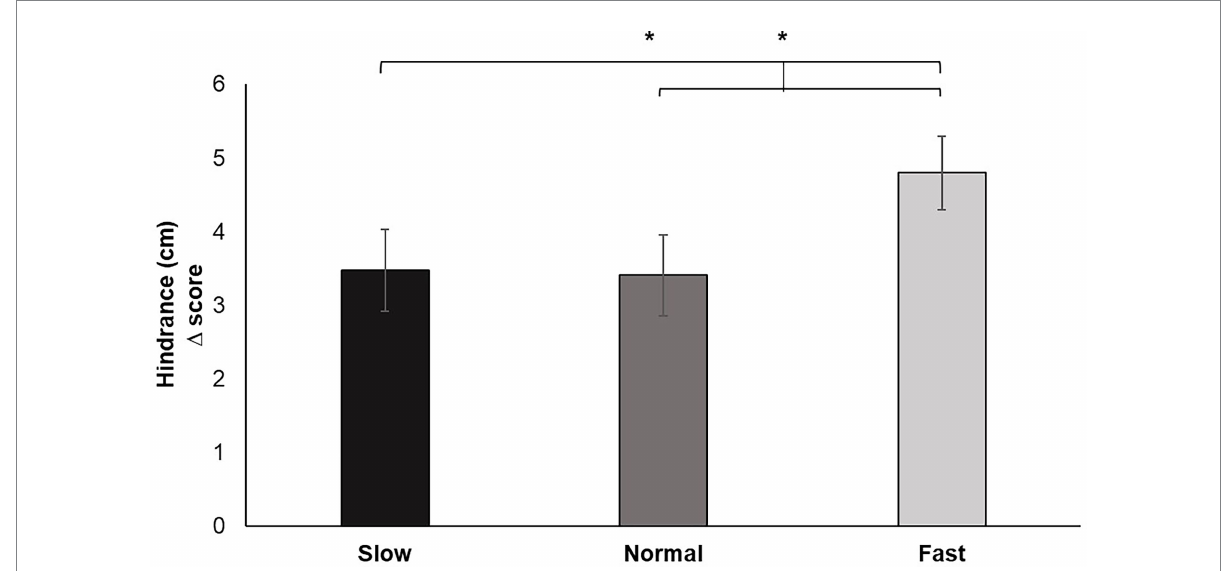
FIGURE 6 Hindrance change scores for each breathing frequency condition in centimeters (cm) on a scale from 1 to 10. Greater values indicate increases in perceived hindrance of breathing to performance of the pinch task. Error bars represent +1 SE from the mean. Asterisks represent significant differences ( p < 0.05).